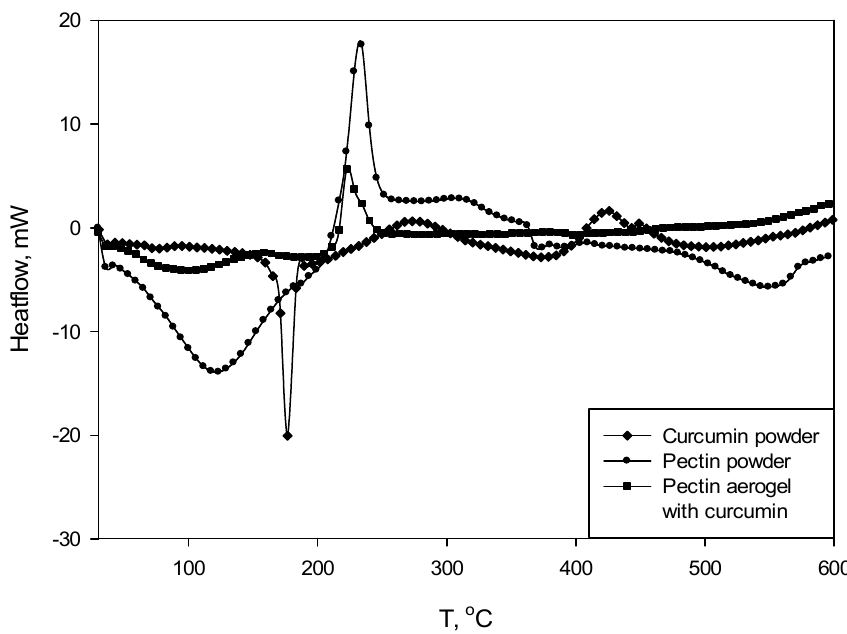
Figure 5. Differential scanning calorimetry (DSC) curves for curcumin powder, pectin powder and pectin aerogel loaded with curcumin.